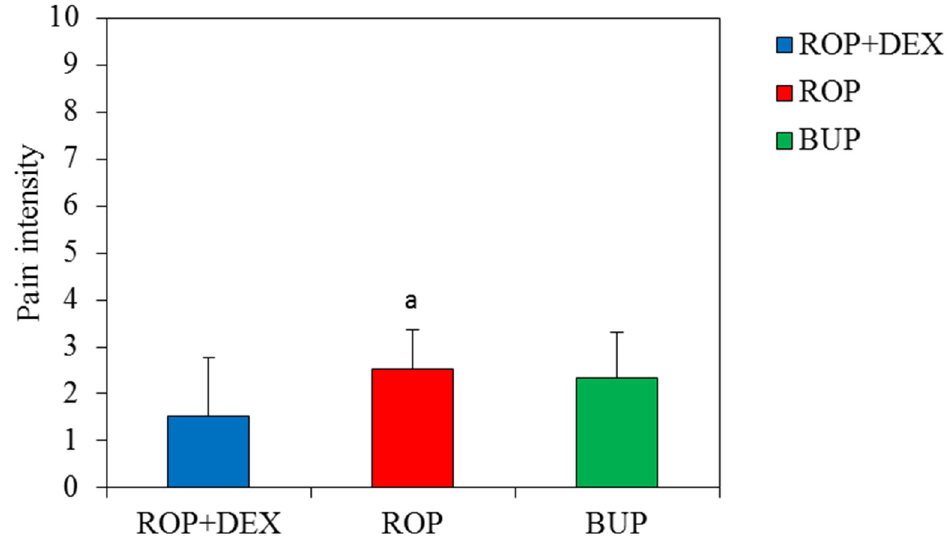
Figure 2. NRS assessment of pain during surgery. Abbreviations: rop + dex (plain 0.5% ropivacaine